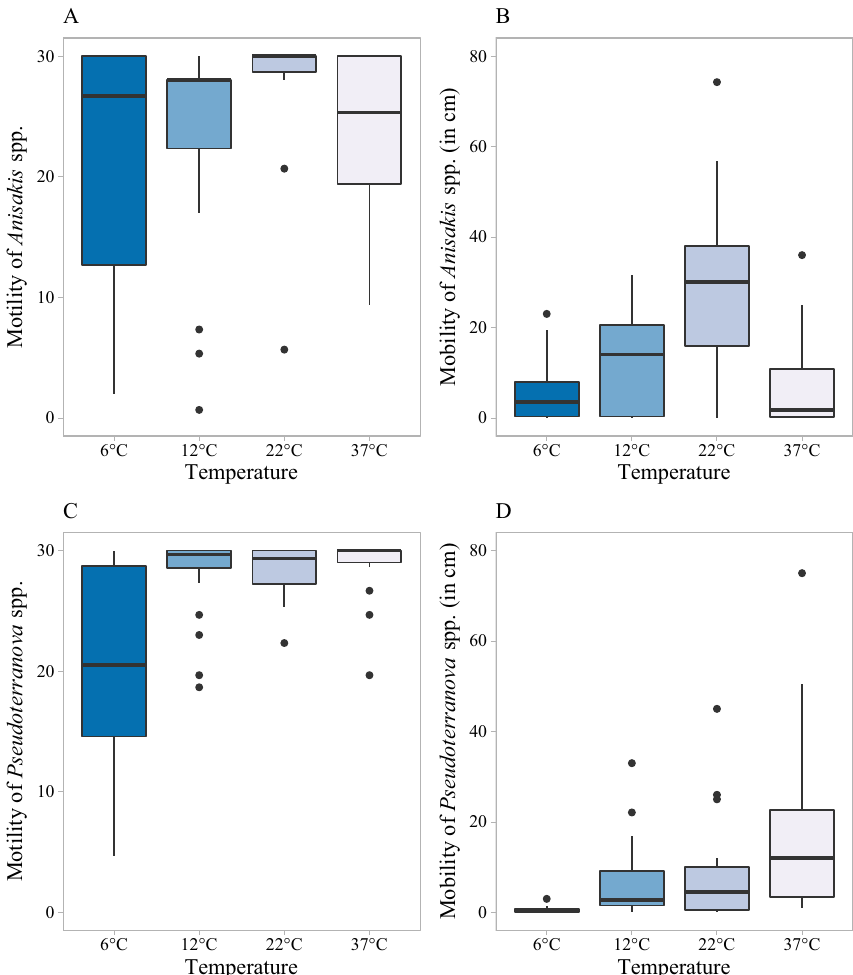
Figure 2. Effect of temperature on larval motility and mobility (in cm) during the first 30 min. (A) Motility of Anisakis spp., (B) mobility of Anisakis spp., (C) motility of Pseudoterranova spp. and (D) mobility of Pseudoterranova spp. under different temperature conditions. The box consists of the upper quartile, median and lower quartile. The whiskers are drawn up to the highest or lowest observed point from the dataset that falls within 1.5 times the interquartile range. Observations beyond the end of the whiskers are plotted individually.